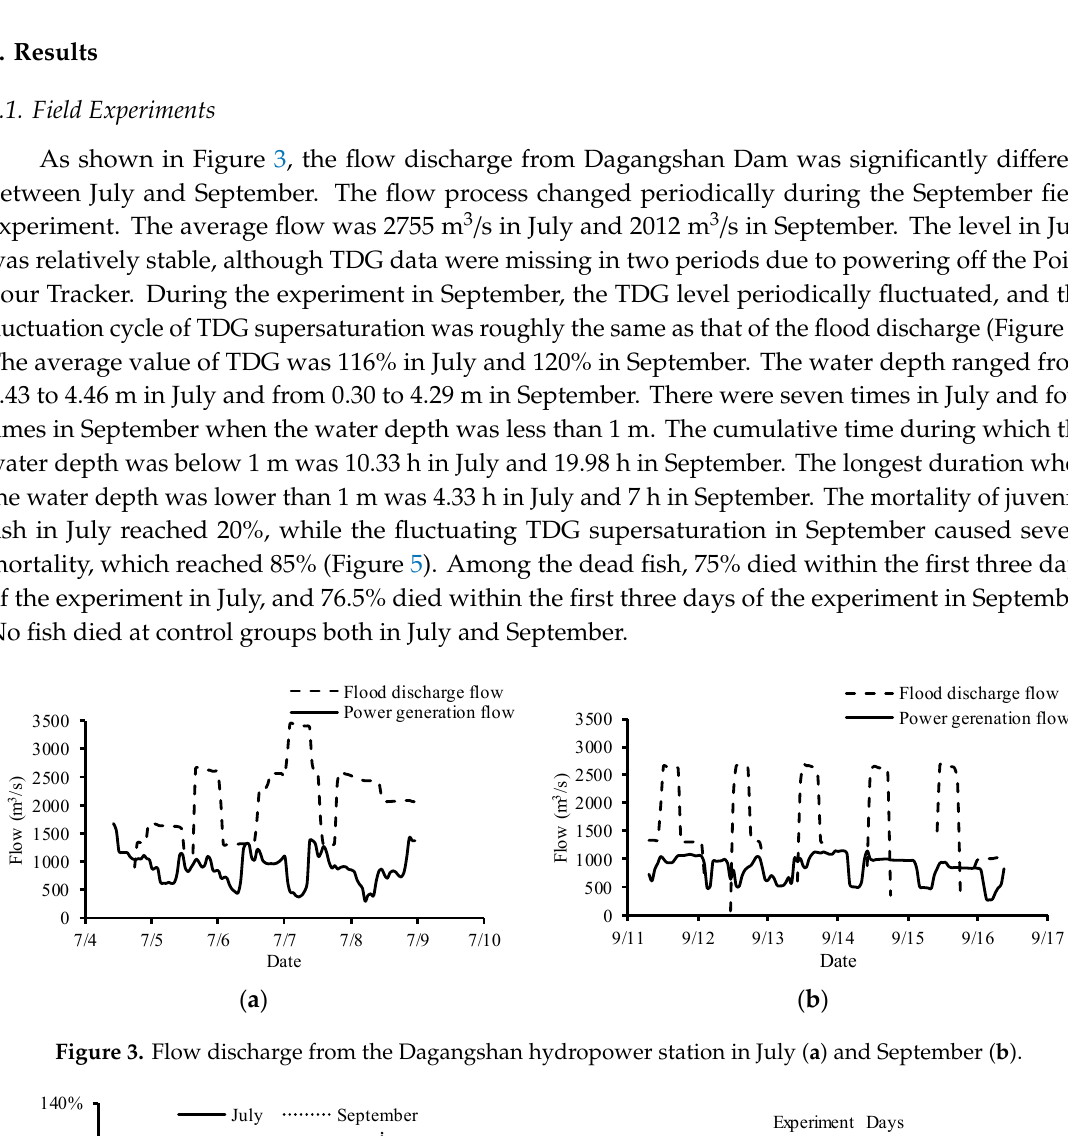
( b ) ( b ) Figure 5. Mortality at the experimental site during the two field experiments, ( a ) and ( b ) represent the mortality in July and September, respectively. TDG data are missing in two periods in July due to powering off the Point Four Tracker. 3.2. Laboratory Experiment The mortality in each case is shown in Figure 6. In the constant TDG test, fish survived well in case CT-1, in which only one fish died (at 71.5 h), and the final mortality of fish in case CT-2 reached 70%. In the cases FT-1(a–c), where the level of TDG fluctuated from 100 to 120%, the final mortalities